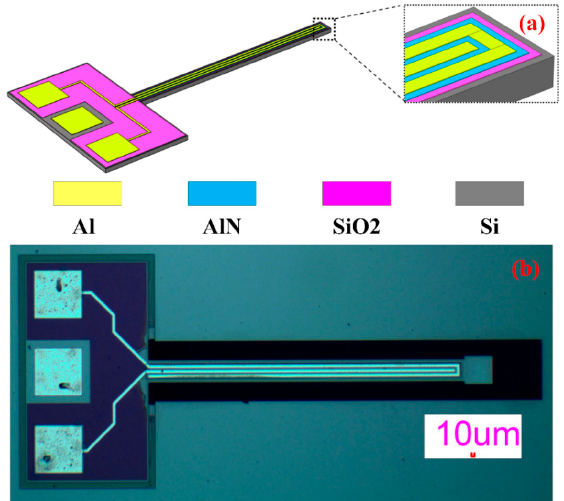
Figure 4. The layout of the piezoelectric cantilever. ( a ) Three-dimensional structure; ( b ) the micro- scope image of one of the piezoelectric cantilevers fabricated using the MEMSCAP piezo microm ‐ achining process.